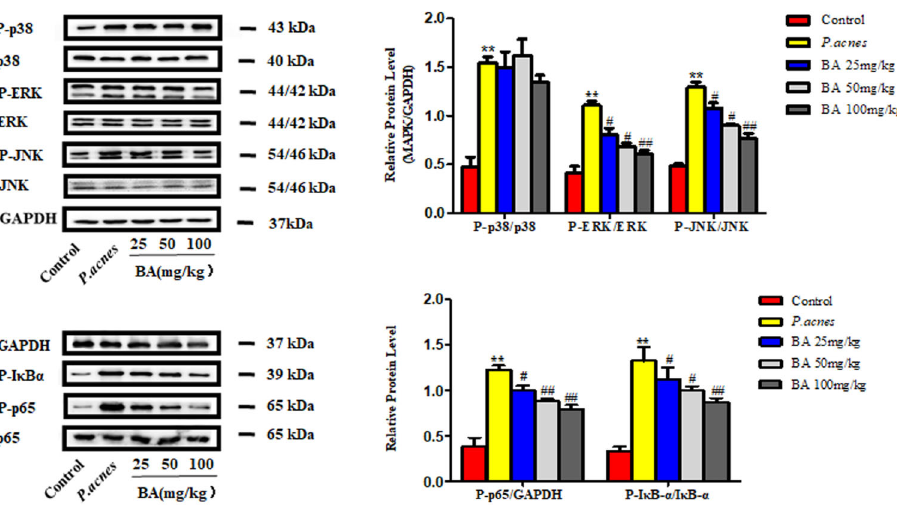
Figure 5. The effects of baicalin (BA) on the MAPK and NF- k B signaling pathways were assessed in vivo . The protein levels of ERK, p38, JNK, I k B a , and P-p65 in the ear tissues of the rats were assessed for each group. The levels of P-ERK, P-p38, P-JNK, and P-p65 were normalized to the levels of ERK, p38, JNK, and p65 proteins, respectively. GAPDH was used as the internal loading control for p-I k B a . The data are reported as means ± SE from at least three independent experiments. **P o 0.01 vs control; # P o 0.05, ## P o 0.01 vs P. acnes alone